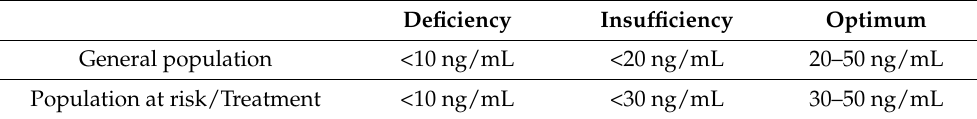
Table 1. ‘ Definitions ’ of Vitamin D Status used (data are grossly